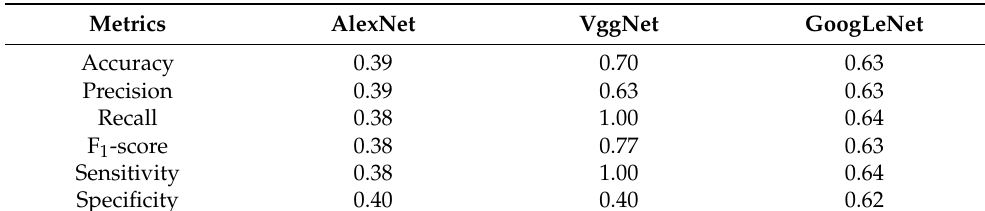
Figure 27. The confusion matrix of three CNN models under different viewpoints. Table 4. Metric comparison under different viewpoints.